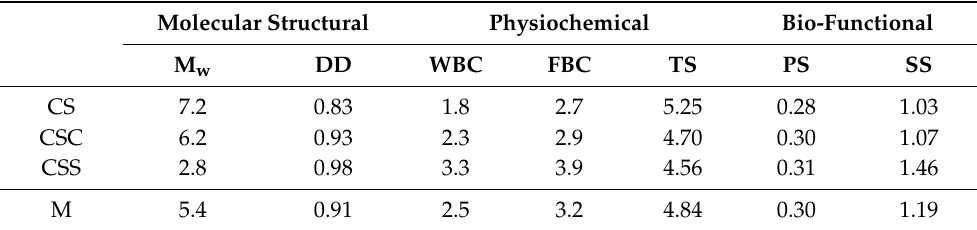
Table 7. Data of chitosan biochemistry performance indexes processed by root